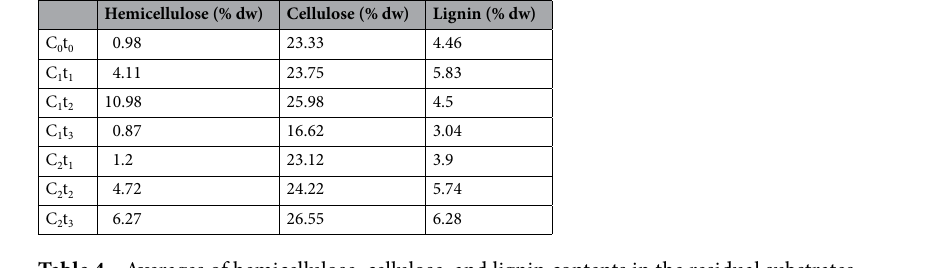
Table 4. Averages of hemicellulose, cellulose, and lignin contents in the residual substrates.